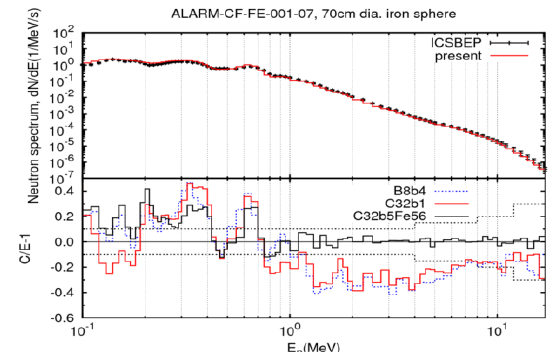
Fig. 8 . The comparison between the calculated neutron spectrum with the new evaluated 56 Fe data and experimental data from the ALARM-CF-FE-001-07, 70cm dia. Iron sphere.